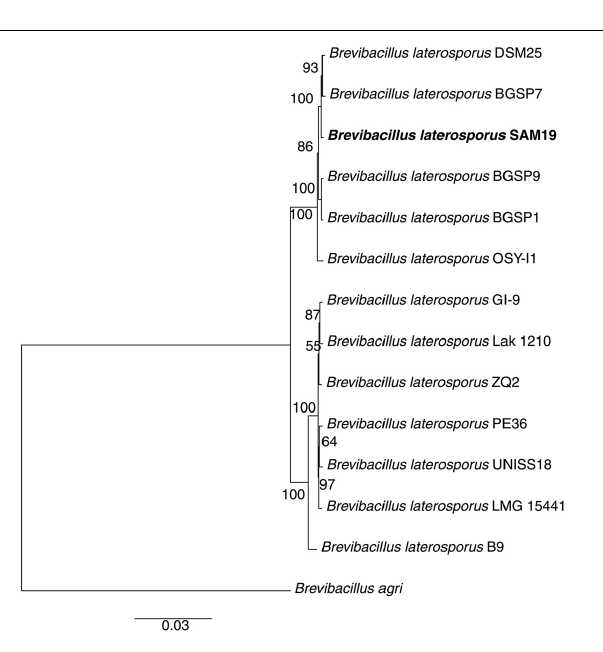
FIGURE 4 | Maximum likelihood phylogenomic tree obtained with RAxML (Stamatakis, 2015) showing the relationships of SAM19 with representative B. laterosporus strains. Numbers of branches stand for bootstrap supports with 100 pseudo-replicates, scale bar for estimated proportional sequence